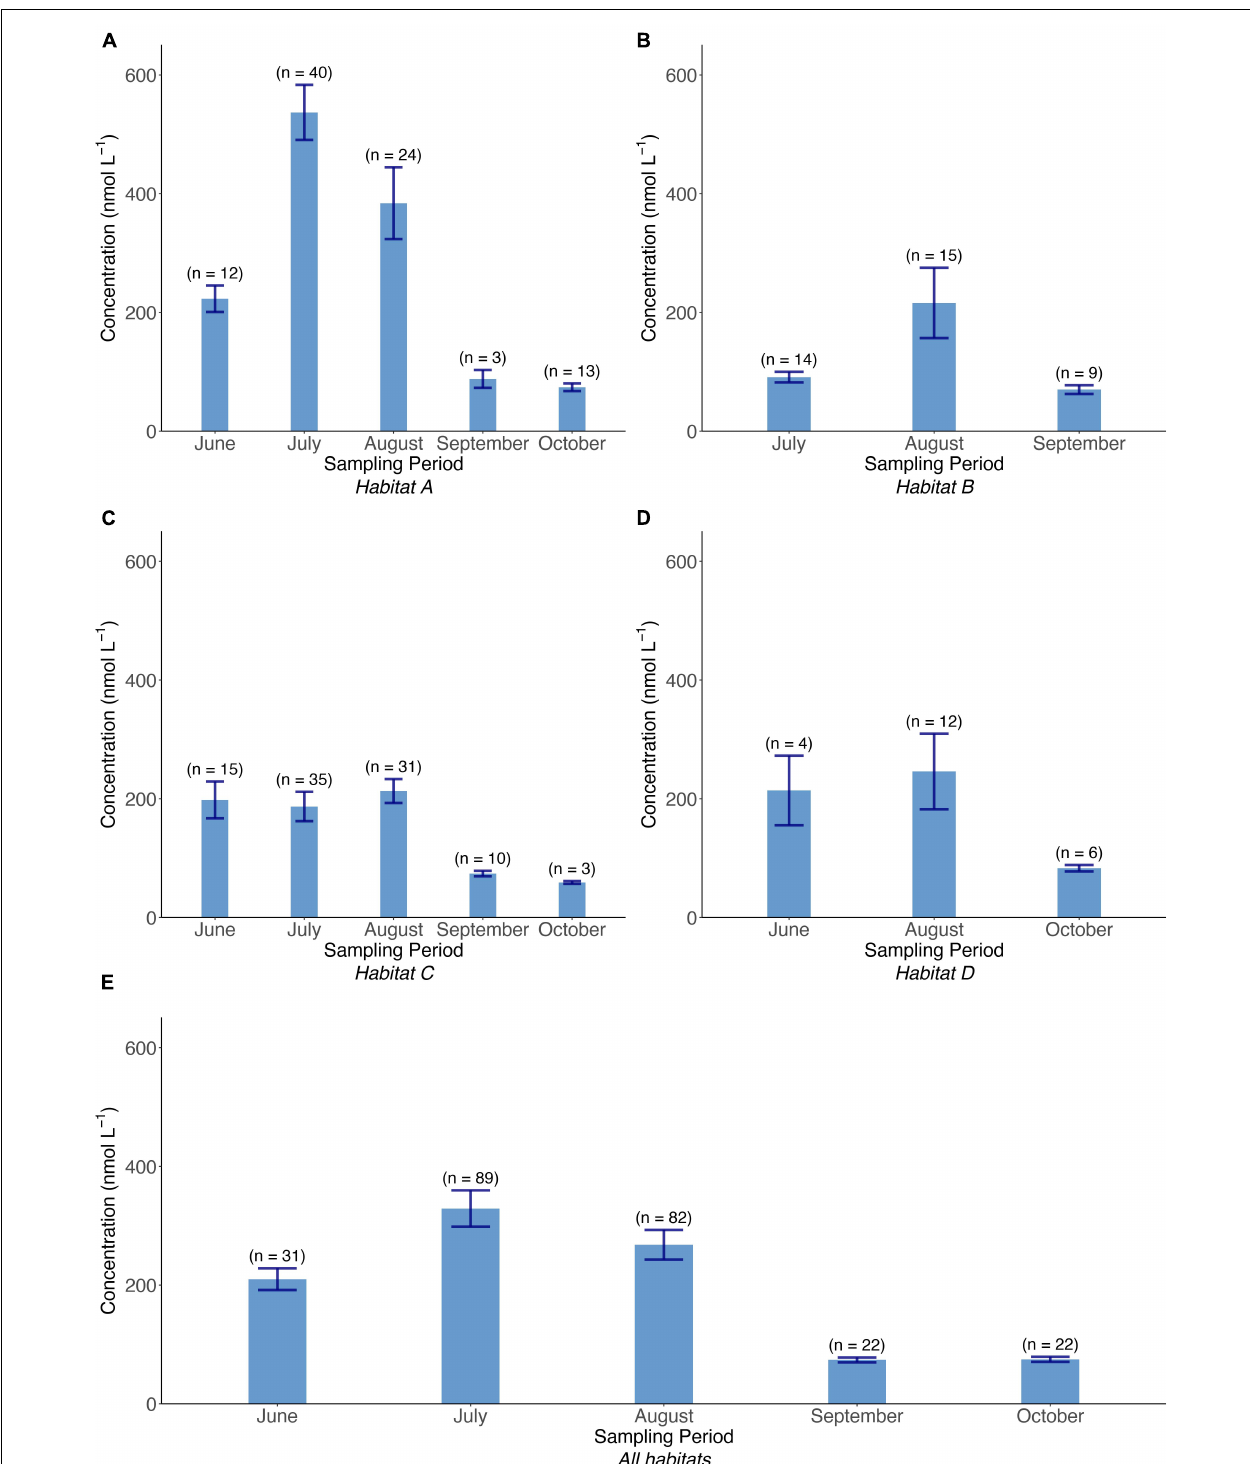
FIGURE 3 | (A–E) Average of water concentration of CH 4 (without outliers) in each habitat and the average of all habitats together during all sampling periods. The standard error of the mean is shown on each bar.